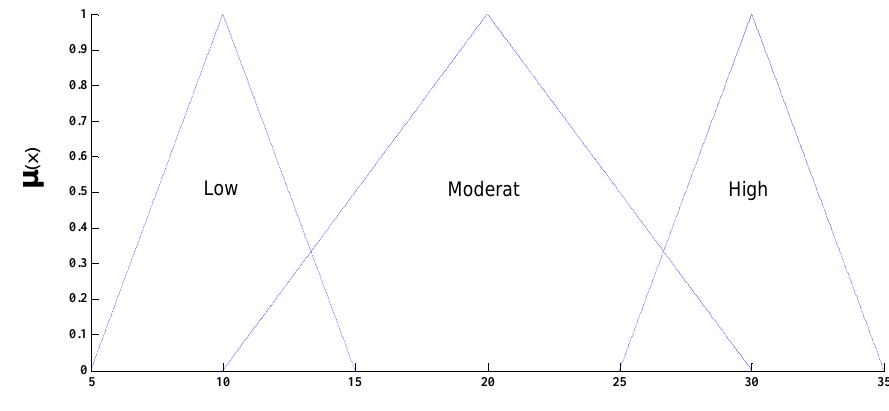
Figure 5: Share of lifestyle drugs in total demand (%) MF Table 1: Key factors in Pharmaceutical industry and their future trends determined by experts Main